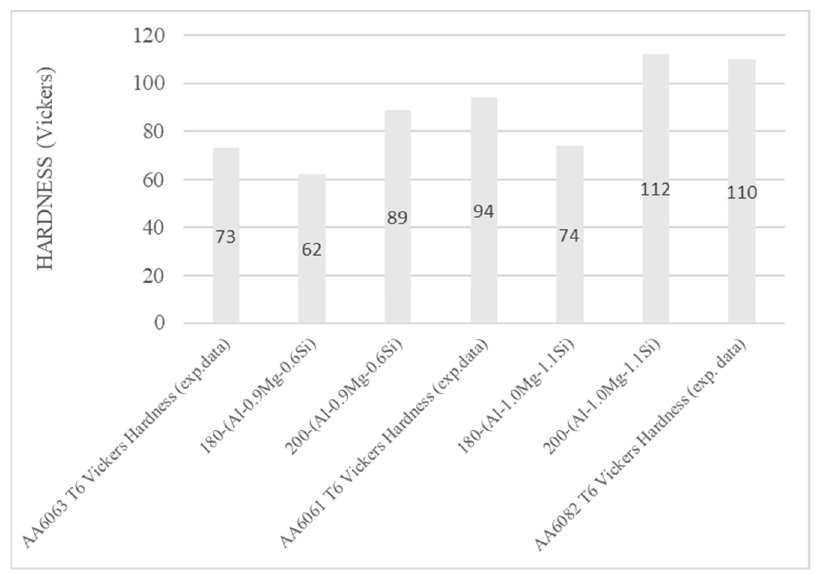
Figure 17. Hardness estimation. Experimental data (AA6061-AA6063-AA6082) from [4,9,37].